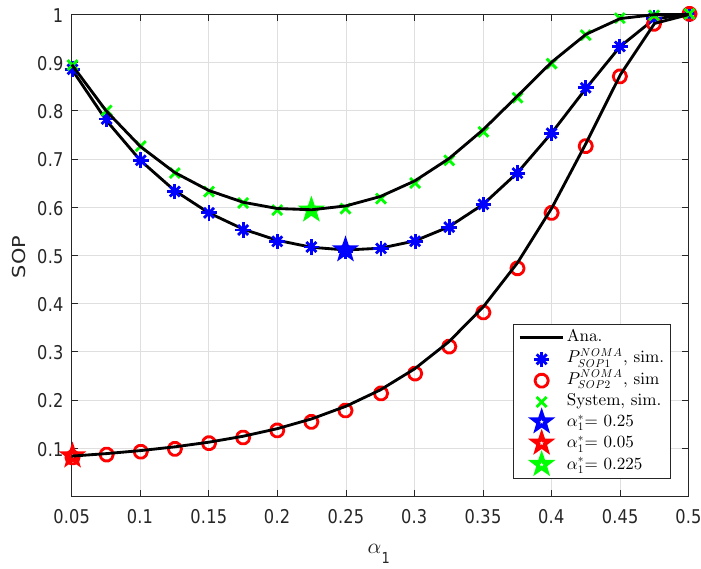
Figure 9. Optimal SOP in several cases with indication of optimal value regarding α 1 ( λ D 1 = λ D 12 = λ SRk = λ kD 2 = λ E = 1, ρ E = − 5 dB, K = 1, R 1 = R 2 =